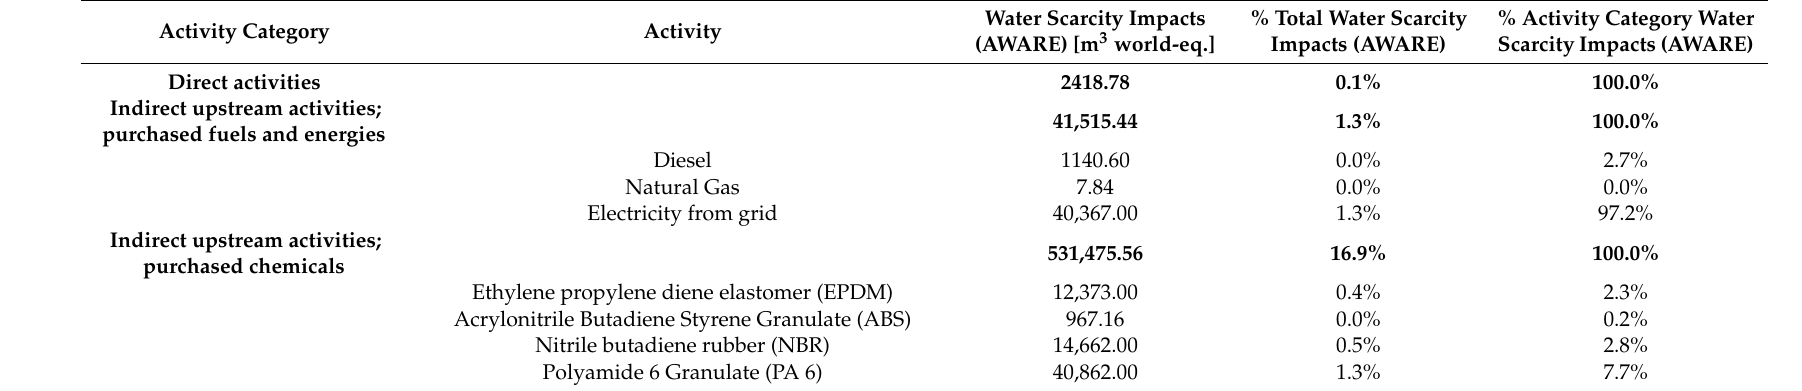
Table A4. Water scarcity footprint results by activity category and activity /